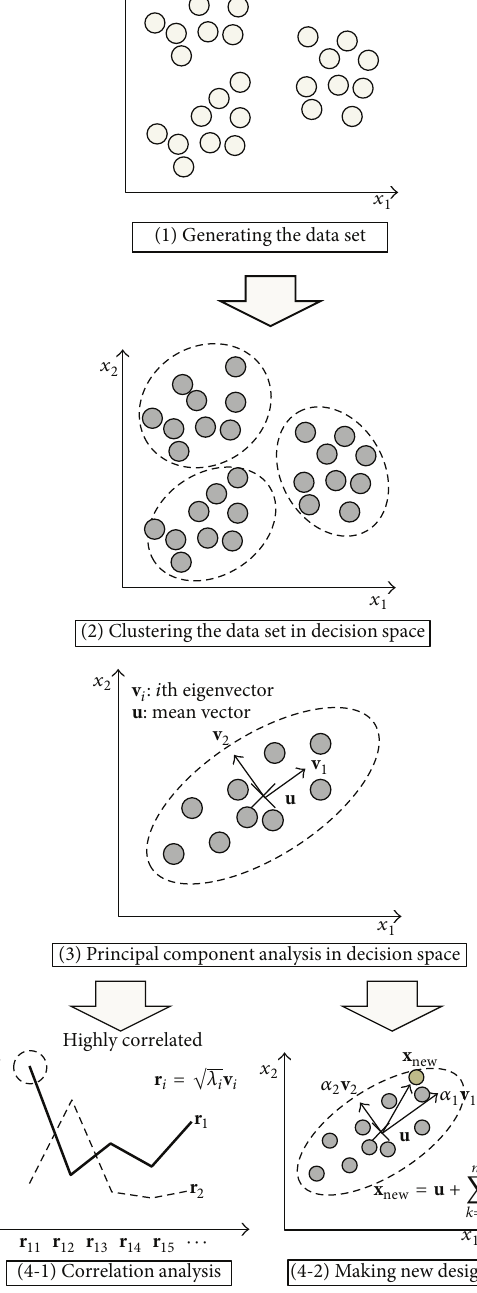
Figure 2: Design mode analysis